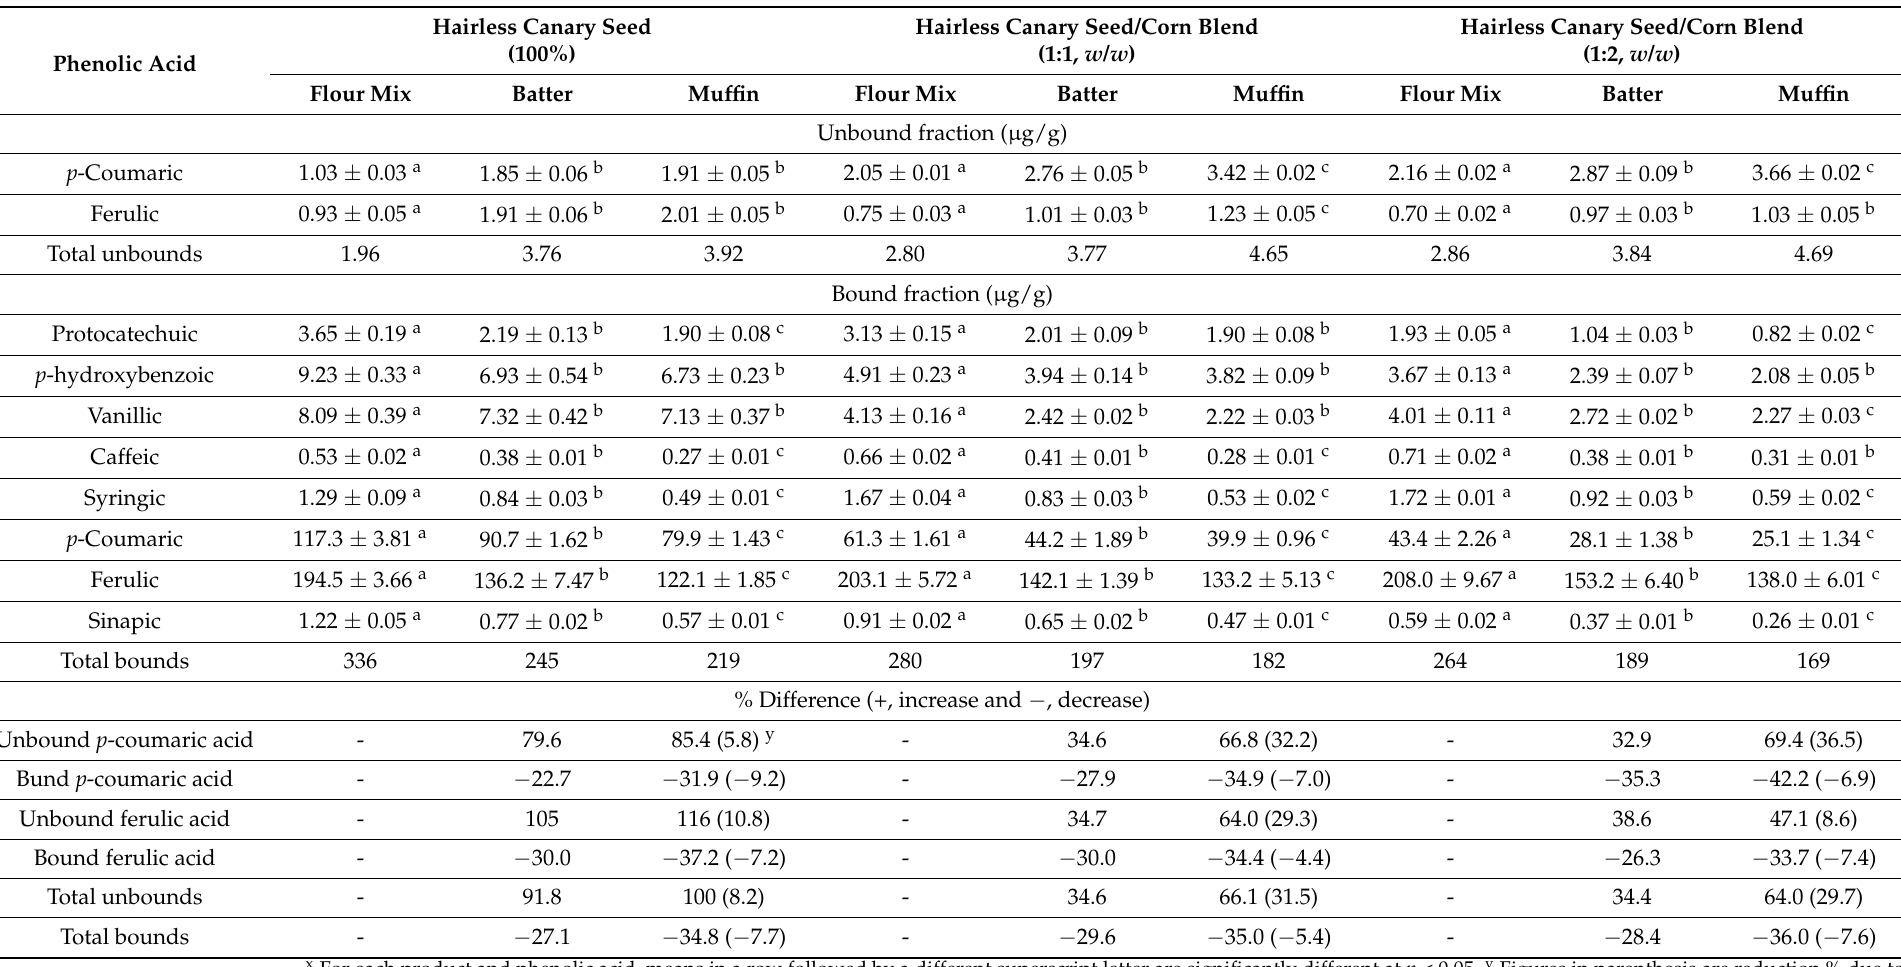
Table 4. Composition of unbound and bound phenolic acids of dry flour mix, batter, and fresh muffin products and the impact of baking process on their concentrations x